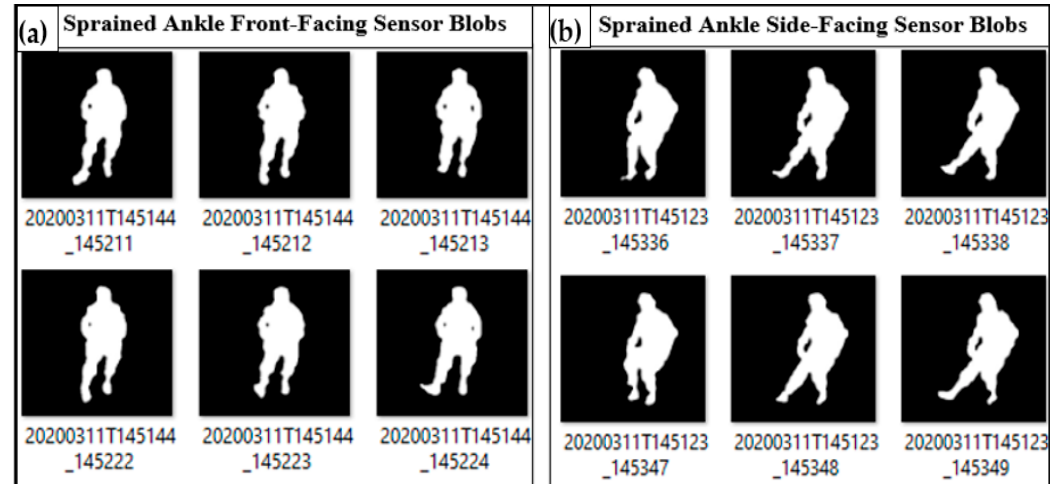
Figure 3. Instances of right-ankle and foot dorsiflexion, plantarflexion, eversion, and inversion as recorded by ITA-32 thermal sensors: ( a ) thermal blobs from the front-facing camera and ( b ) thermal blobs from the side-facing camera.